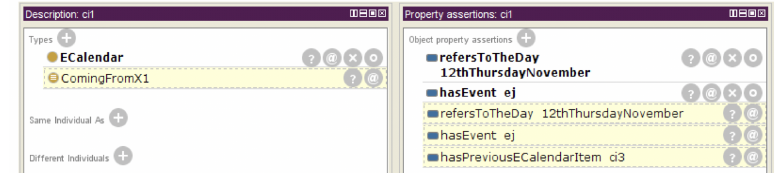
Figure 10. Individual ci 1 is classified as an instance of